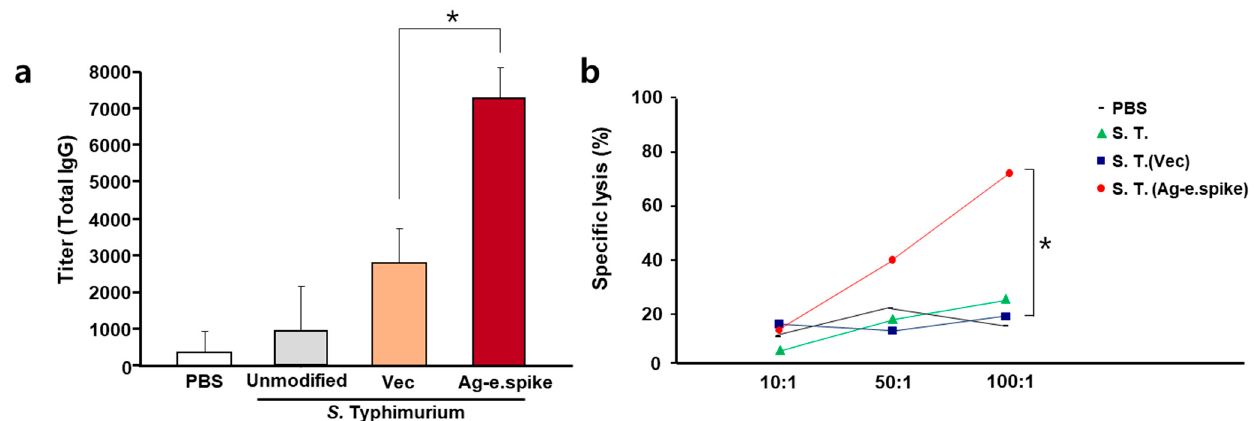
Figure 4. In vivo effects of oral treatment with S. Typhimurium expressing Ag-e.spike. Balb/c mice were orally inoculated on days 1, 14, and 28 with PBS or with 1 × 10 7 CFU of attenuated unmodified S. Typhimurium, S. Typhimurium carrying the empty expression vector (vec), or S. Typhimurium expressing Ag-spike. ( a ) Mice were bled every 2 weeks, and total IgG antibody titer was determined by ELISA using equally pooled sera samples from each experimental group. ( b ) Comparison of S protein-specific CTL activities in BALB/c mice orally immunized with 10 7 bacteria cells at 0, 2, and 4 weeks. One week after the last immunization, spleen cells were obtained and restimulated in vitro with the recombinant S protein-pulsed syngeneic stimulator cells. The specific cytolytic activity was tested against syngeneic targets in an LDH release assay. Spleen cells from unimmunized mice were used as control. Results represent mean specific lysis values from representative individual mice tested at the indicated effector:target cell ratios. (* p < 0.05 versus S. typhimurium (Vec)-treated mice;